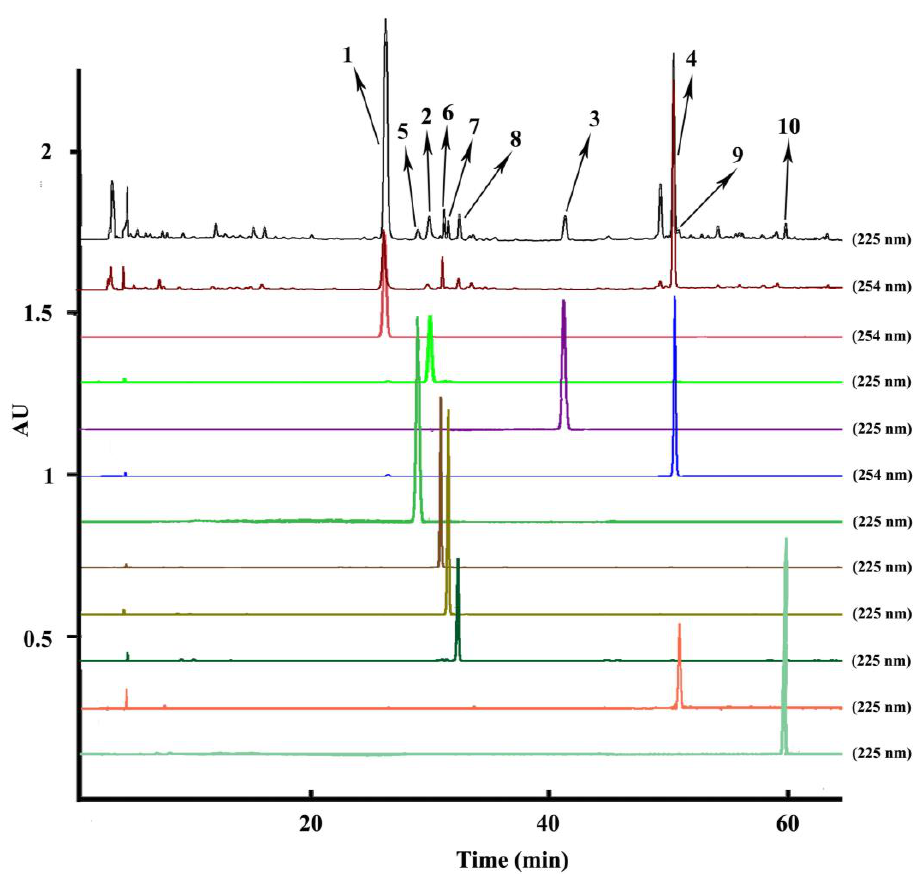
Figure 2. HPLC chromatograms of the extraction sample and peak fractions from Andrographis paniculata . HPLC conditions: column: Eclipse Plus C8 (250 mm × 4.6 mm i.d., 5 μm); mobile phase: